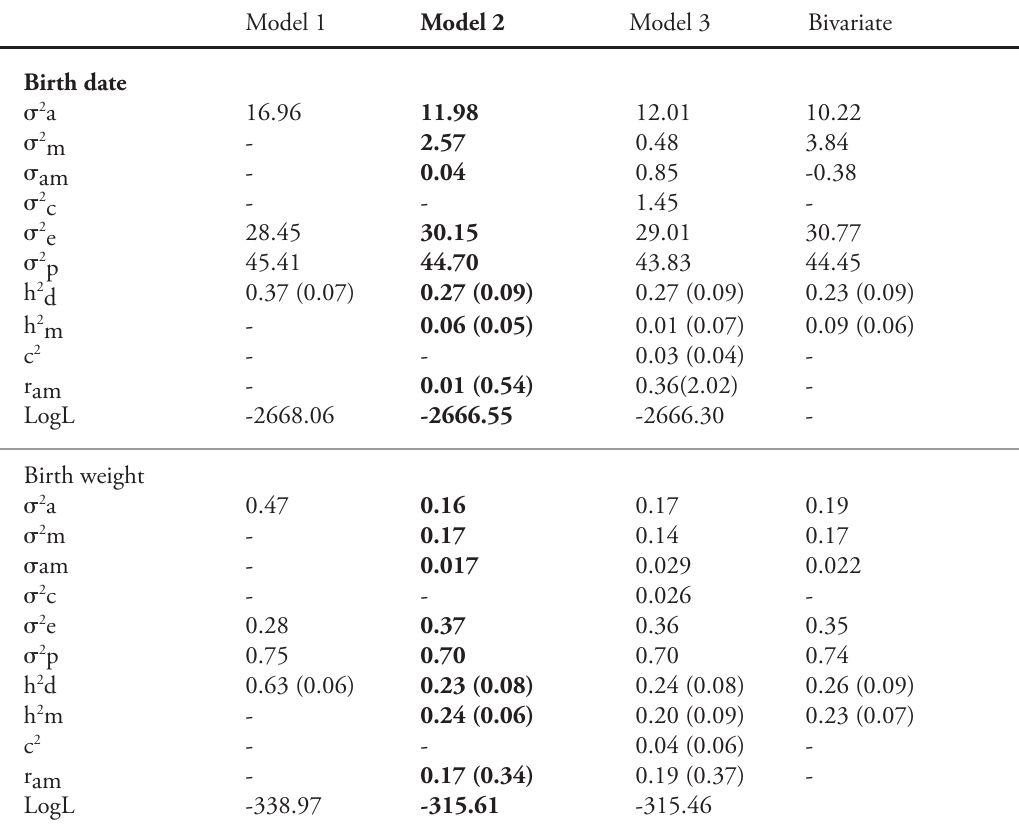
Table 4. Estimates of (co)variance components and genetic parameters (standard error in parentheses) for birth date and birth weight in the Kutuharju reindeer herd in 1987–2011. Models 1–3 have following random effects: 1 = animal, 2 = animal + maternal genetic, and 3 = animal + maternal genetic + maternal permanent environmental effect. The best model is indicated in bold and used in bivariate context giving the (co)variance components of an analysis of BD and BW together.